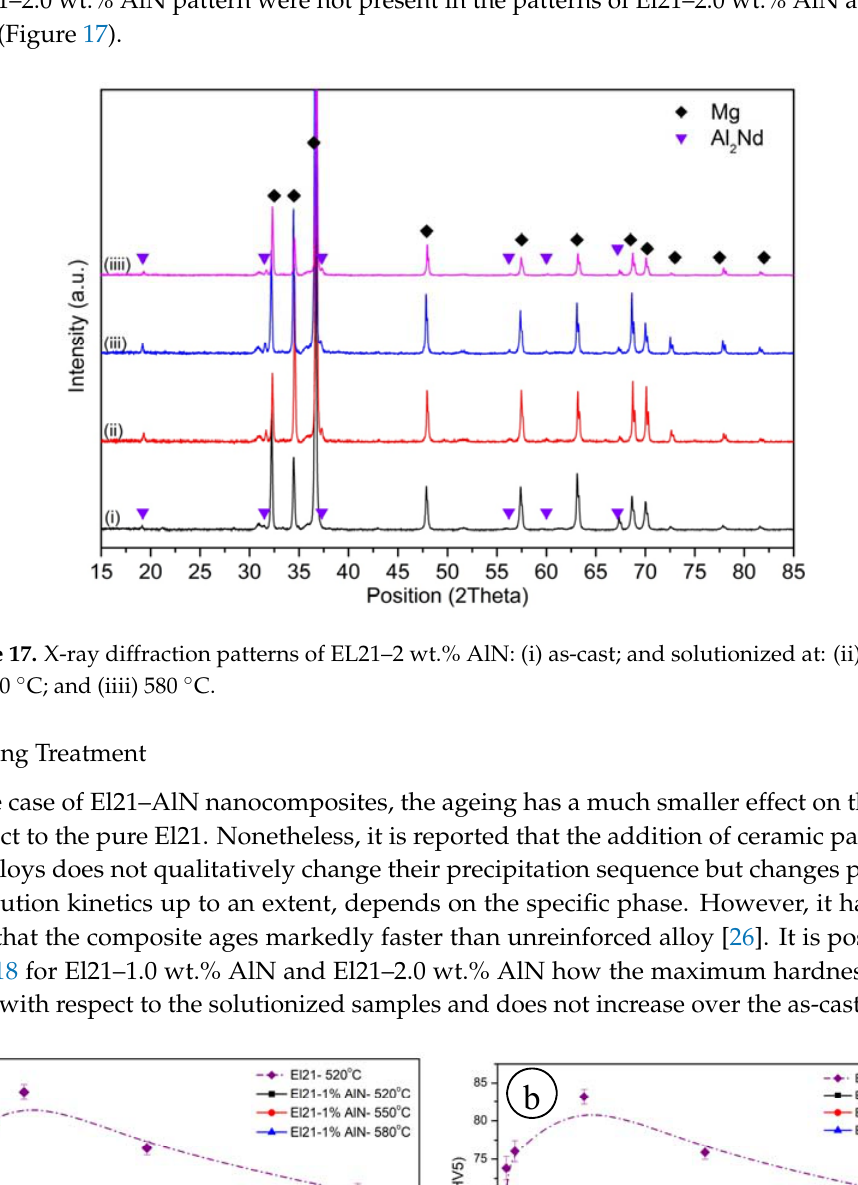
Figure 16. X ‐ ray diffraction patterns of EL21–1.0 wt.% AlN: (i) as cast; and solutionized at: (ii) 520 °C; (iii) 550 °C; and (iiii) 580 °C.